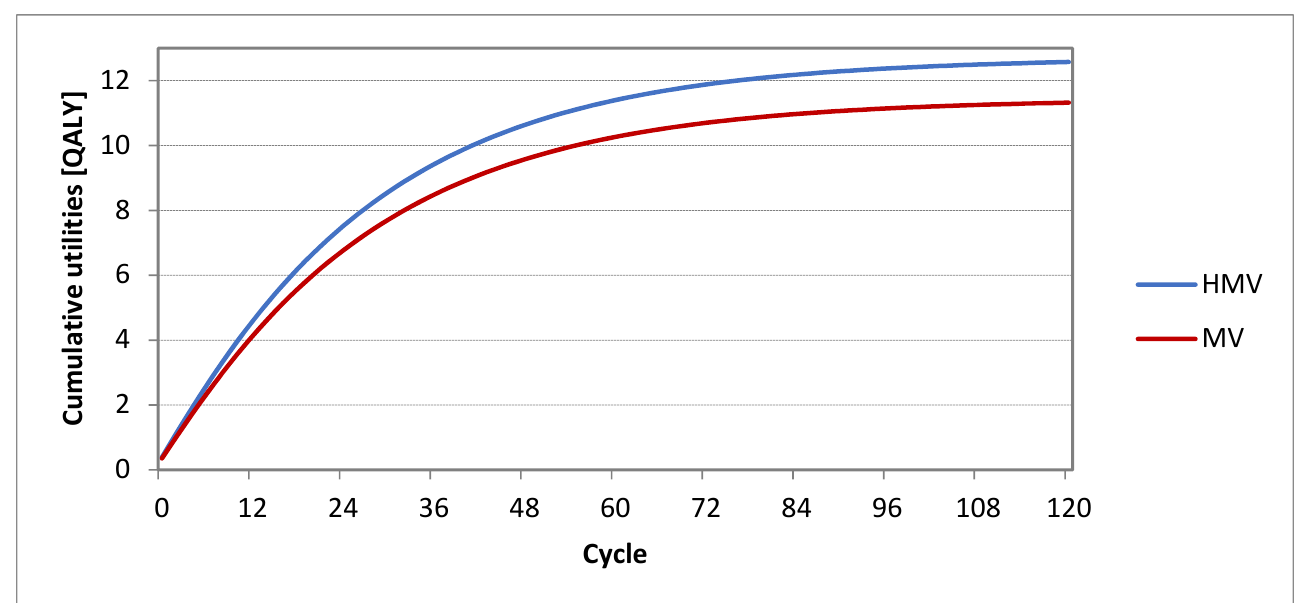
Figure 5. Cumulative utilities.